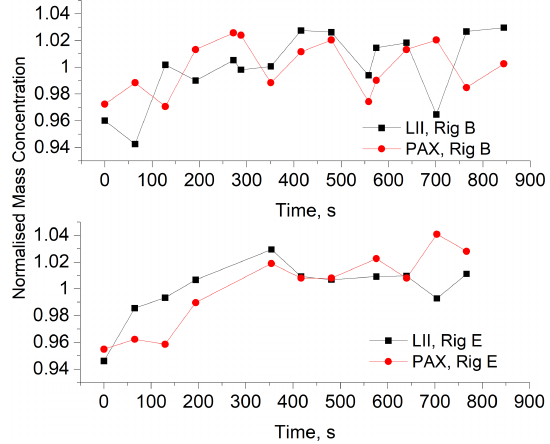
Figure 3. Mass concentration (normalised) measurements by the PAX and the LII 300 at its reference laser fluence points during fluence sweep tests using two different sources: nvPM emissions from the IP combustor (Rig B) and from the diesel engine (Rig